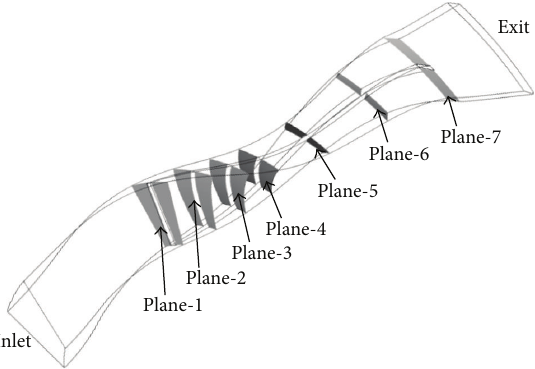
Figure 19: Observation planes in streamwise direction from inducer inlet to impeller exit.